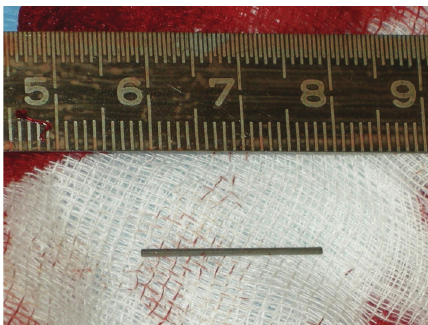
Figure 3: Photo of removed metallic tube.